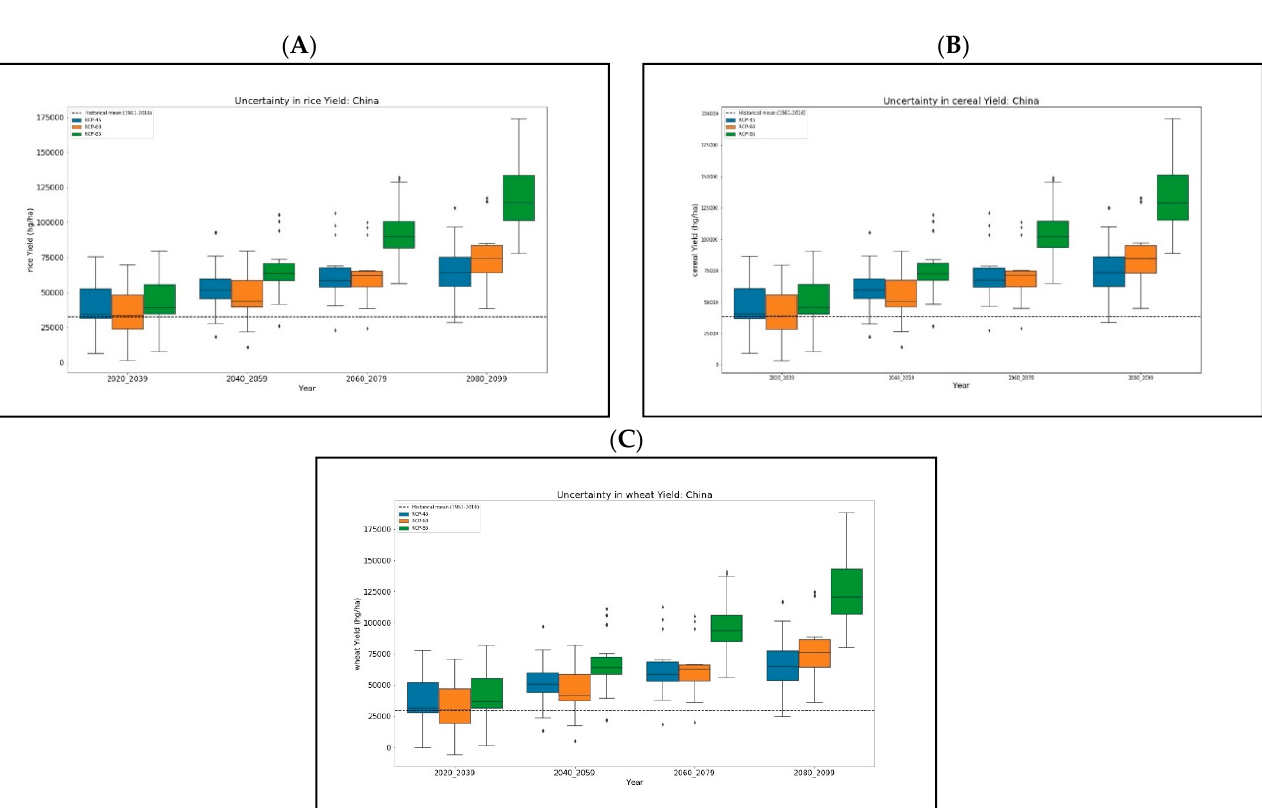
Figure 3. ( A ) Crop yield uncertainty projection in China—case Rice. ( B ) Crop yield uncertainty projection in China—case Cereal. ( C ) Crop yield uncertainty projection in China—case wheat.